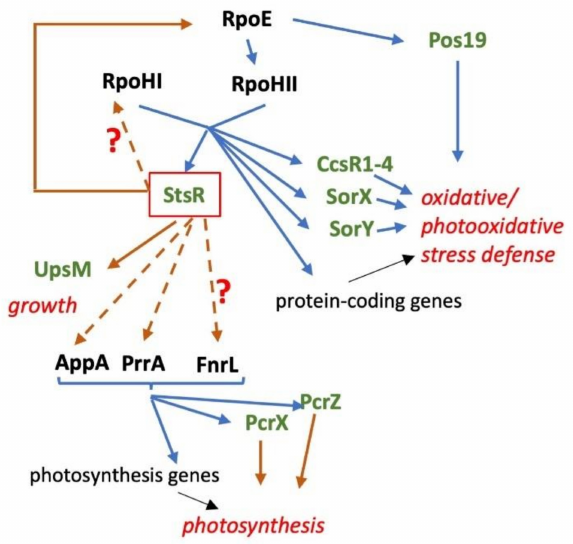
Figure 1. Schematic overview of the regulatory network of sRNAs (green) and proteins (black) affecting the photooxidative stress response and expression of photosynthesis genes. Blue arrows indicate activation, brown arrows